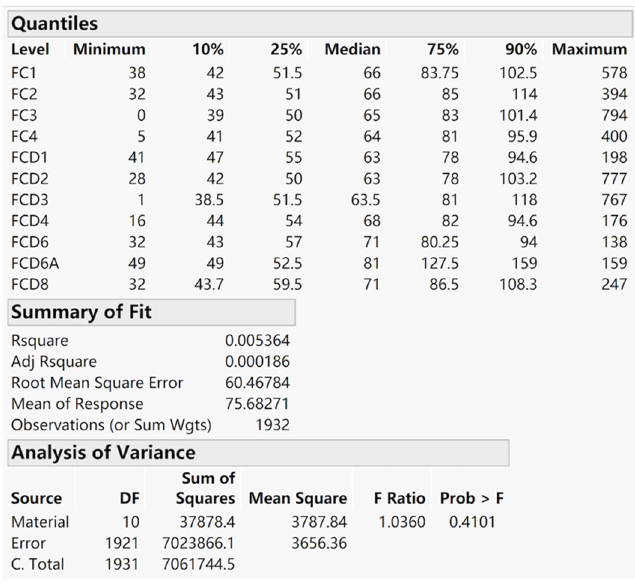
Figure 6. ANOVA: Molten-metal-making times versus 11 materials.